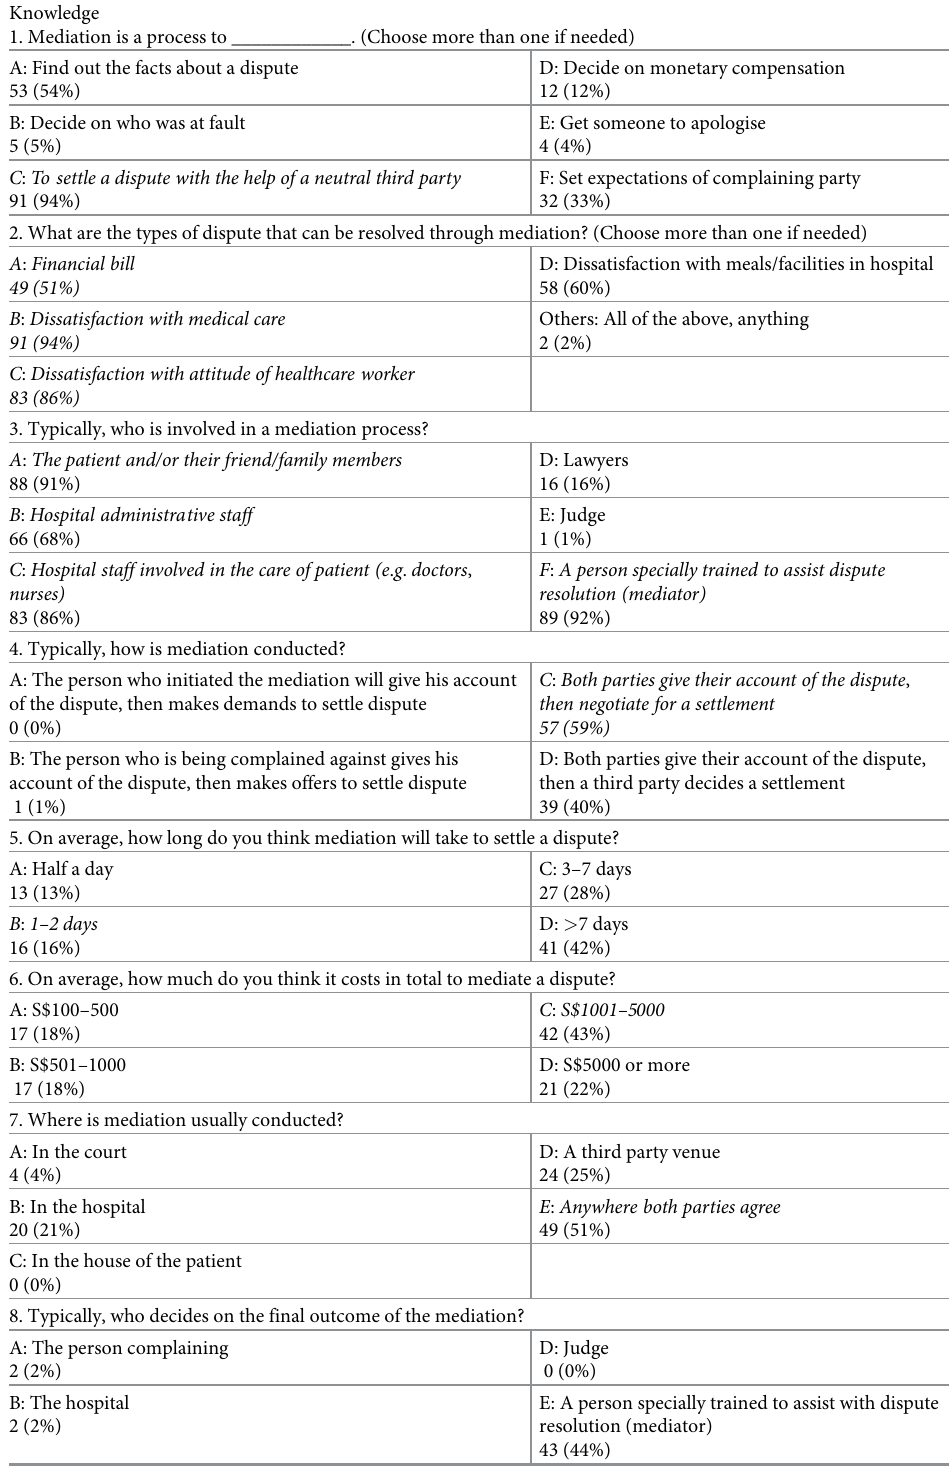
Table 1. Summary of the responses to the survey